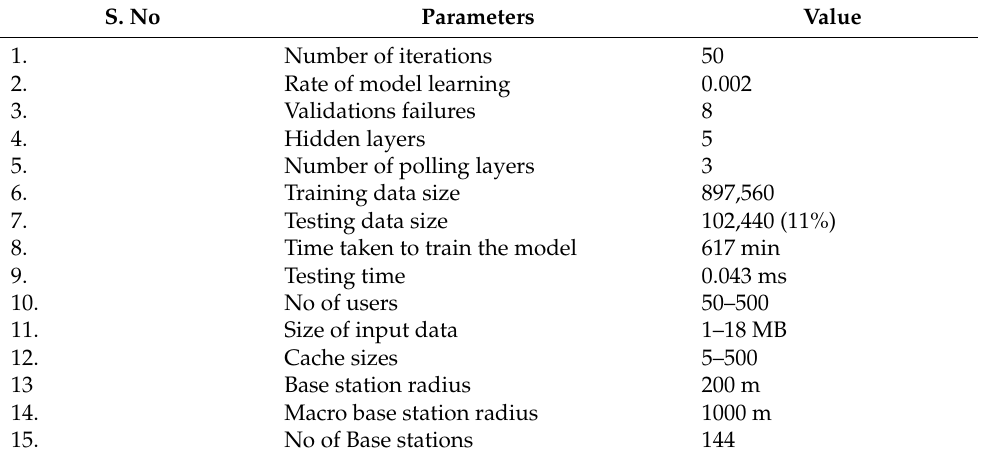
Table 4. Simulation settings and modeling